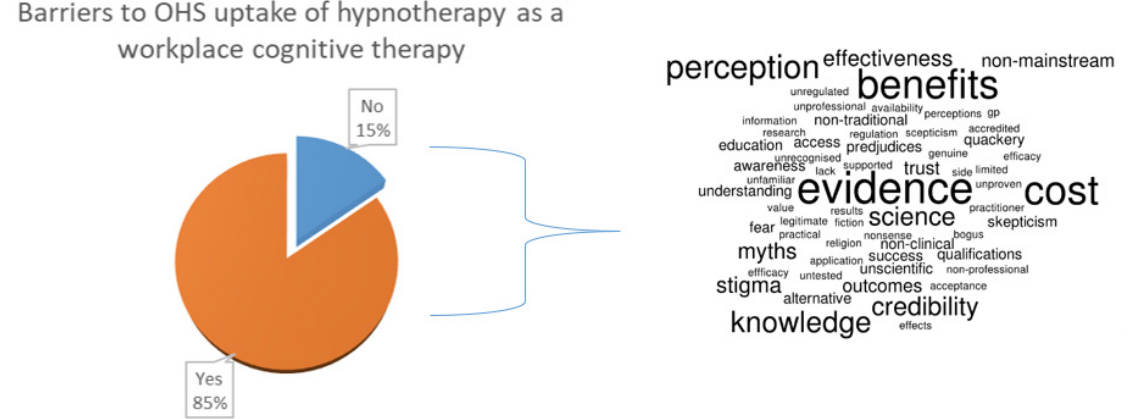
Figure 3. Perceived barriers towards hypnotherapy as an OHS offering.